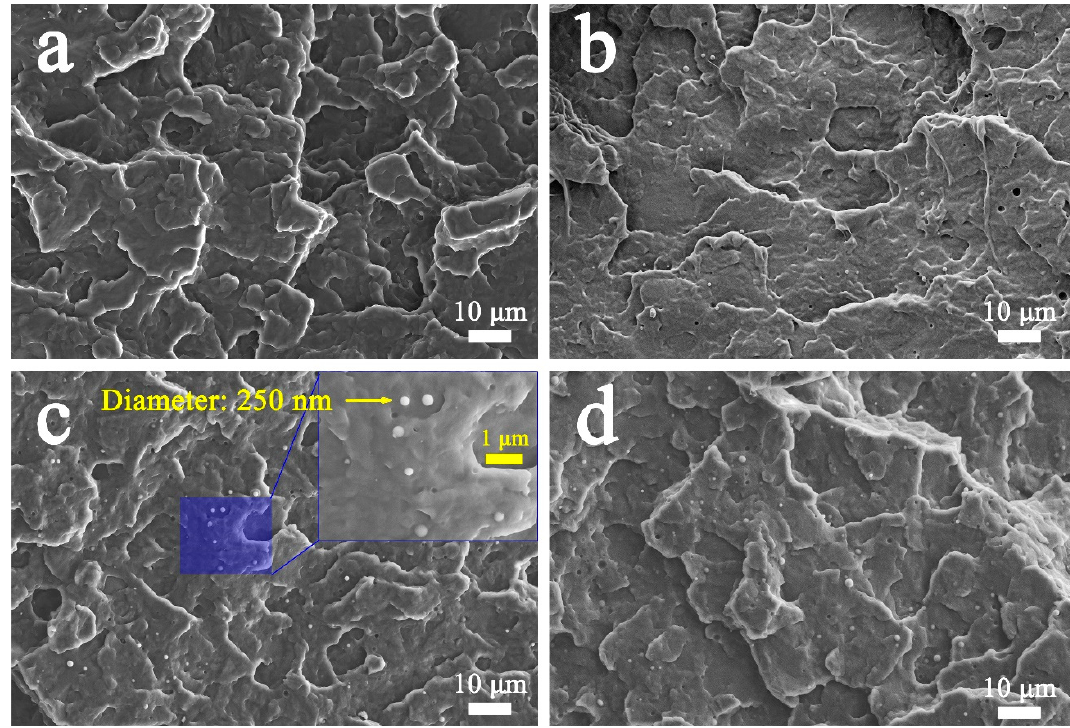
Figure 1. SEM images of fractured surfaces of ( a ) neat PP, ( b ) PP/FKM(0.5), ( c ) PP/FKM(1.0), and ( d ) PP/FKM(2.0) samples.